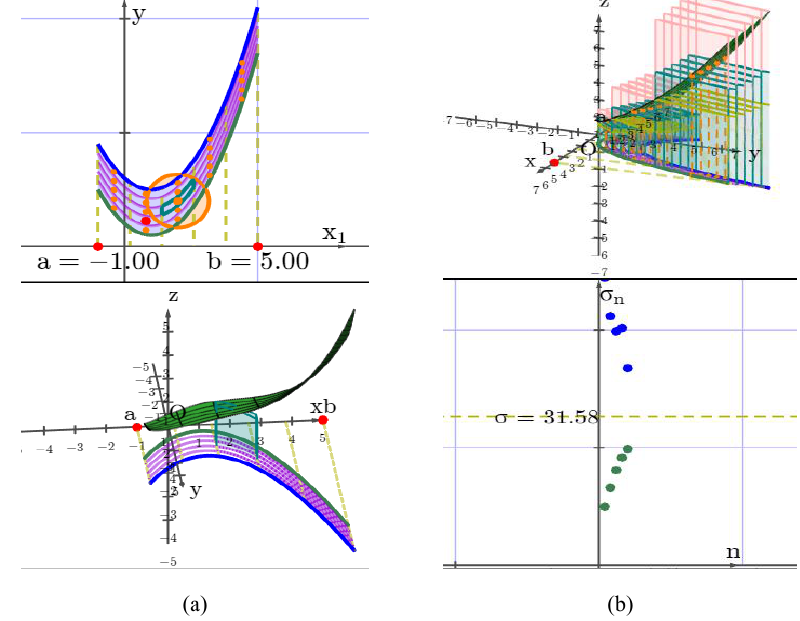
Fig.1. Visualization in the Nomotex DLS: (a) visualization of the definition "Integral sum"; (b) visualization of the proof of the theorem "Darboux's